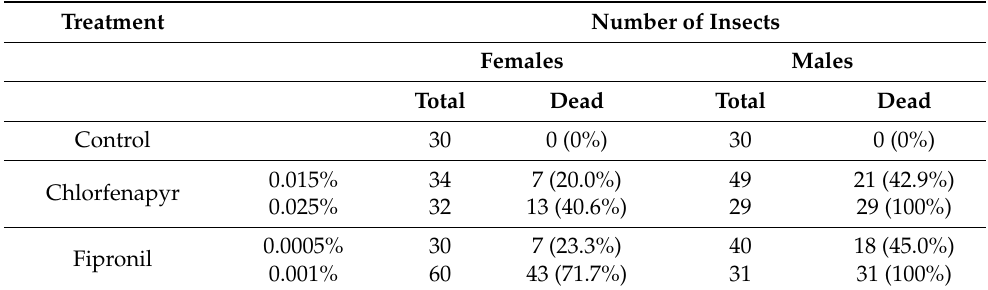
Table 1. Mortality of adults Musca domestica at 24 h after exposure to insecticides.